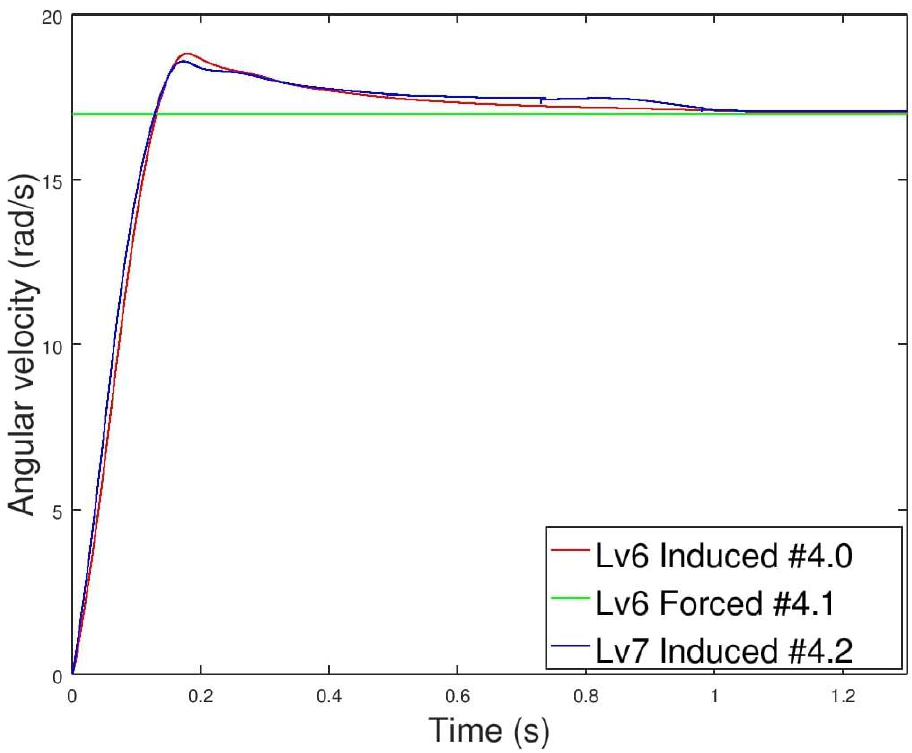
Figure 29. Time evolution of the angular velocity for cases #4.0 (red line), #4.1 (green line) and #4.2 (blue line).